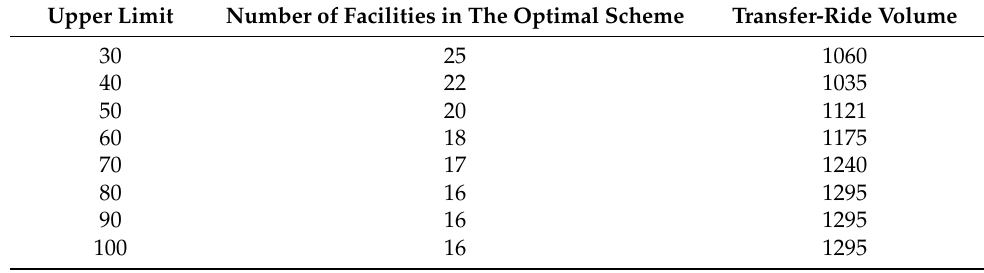
Table 7. Change of optimal layout scheme with the upper limit.